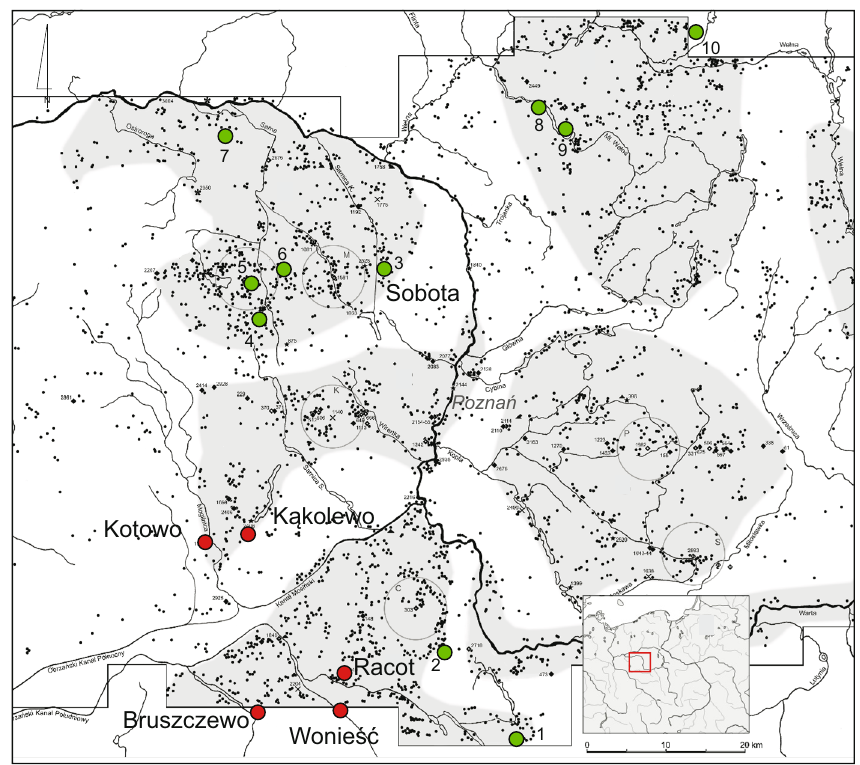
Figure 1: The distribution of FBC sites in the Middle Warta catchment ( after Wierzbicki, 2013 ) . Red dots – sites mentioned in the text. Green dots – potential megalithic cemeteries: ( 1 ) Dolsk district Ś rem; ( 2 ) Wyrzeka district Ś rem; ( 3 ) Sobota district Pozna ń ; ( 4 ) Sierpówko district Szamotu ł y; ( 5 ) Ka ź mierz district Szamotu ł y; ( 6 ) Chlewisk district Szamotu ł y; ( 7 ) S ł opanowo district Szamotu ł y; ( 8 and 9 ) Budziszewko district Oborniki; ( 10 ) St ę puchowo district W ą